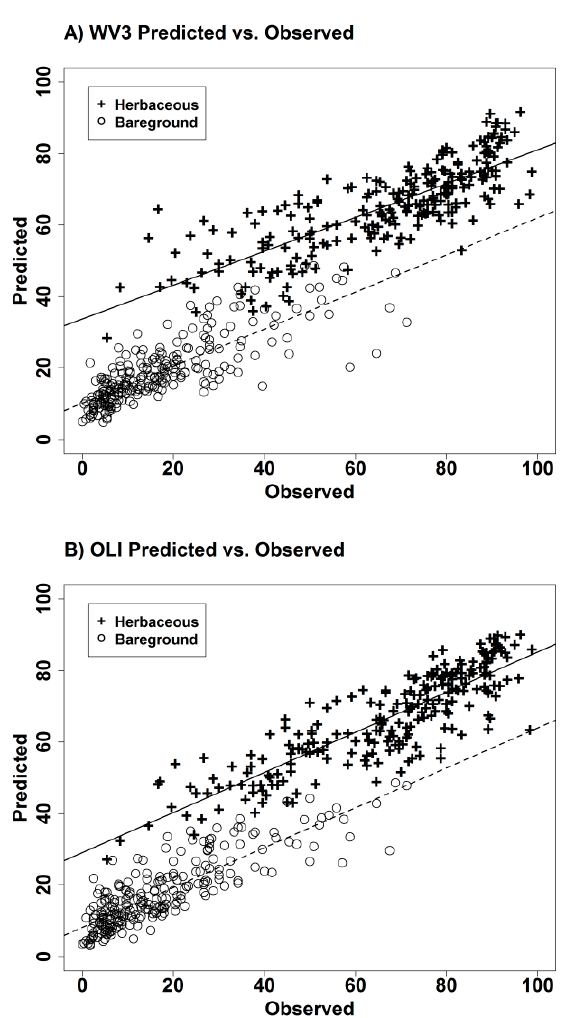
Figure 12. Scatter plot of predicted and observed herbaceous and bare ground percent cover from ( A ) Worldview-3 and ( B ) Operational Land Imagery satellite imagery and field plots.